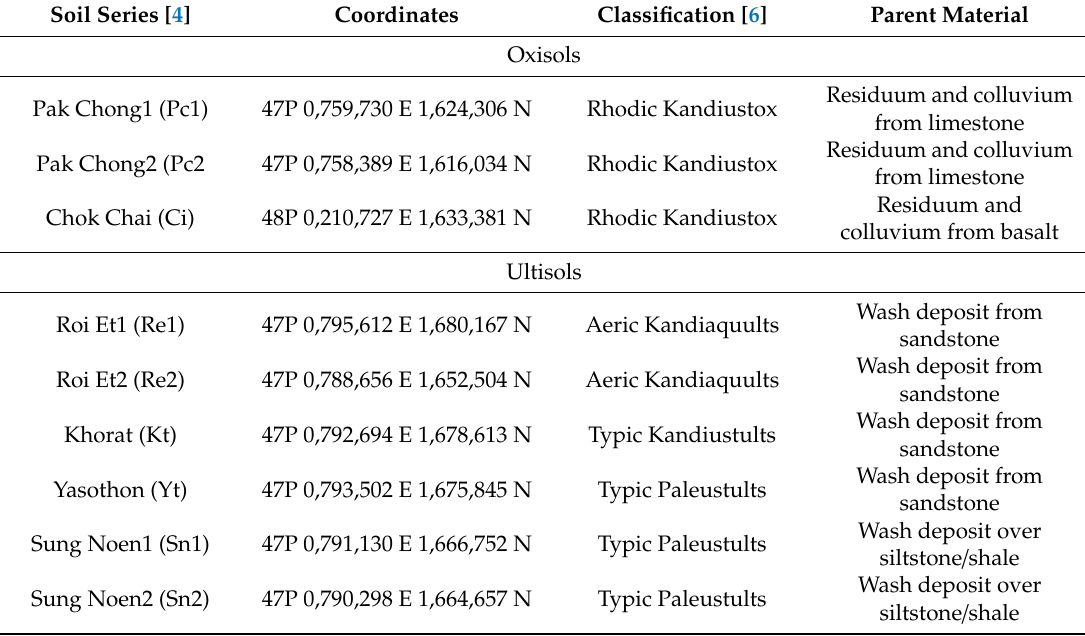
Table 1. Soil series, location, classification, and parent material of soils used in the study.